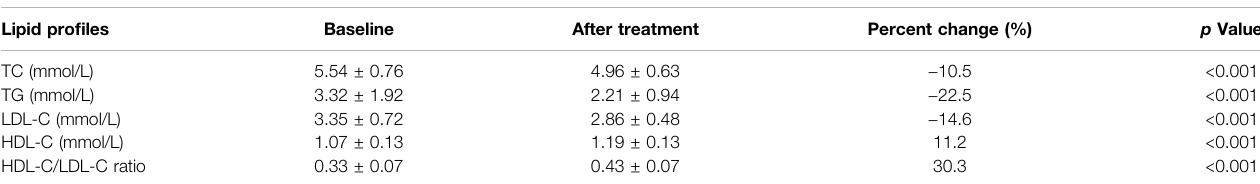
TABLE 2 | Changes of lipid pro fi les after Xuezhikang treatment. Lipid pro fi